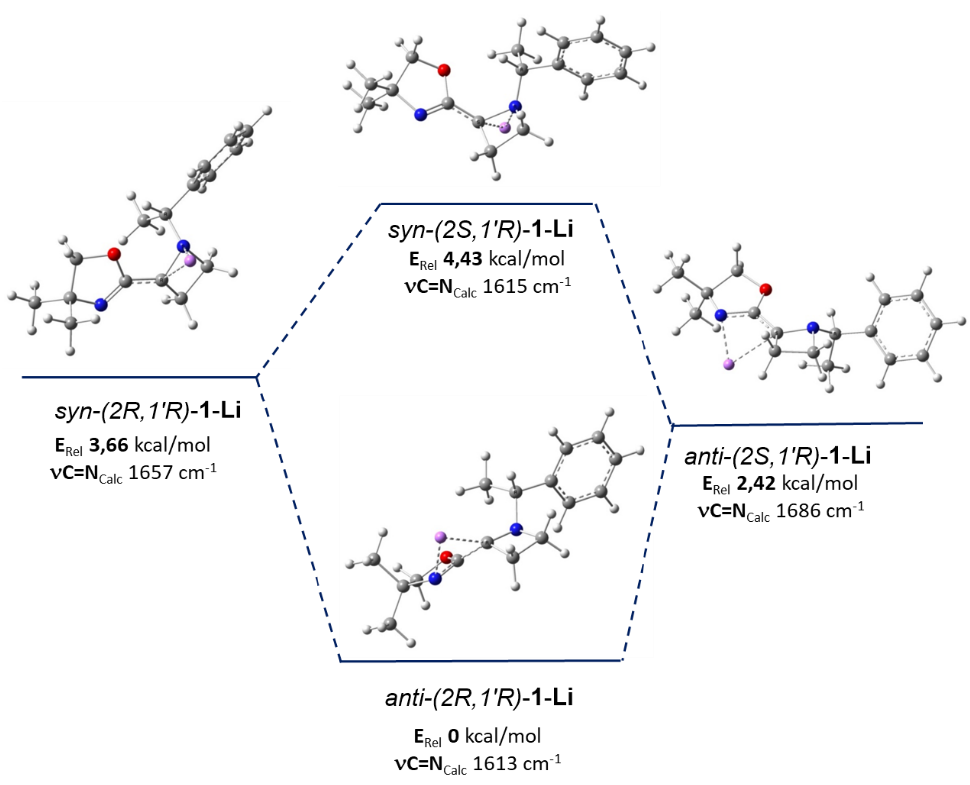
Figure 4. DFT studies towards computing wavenumber for C=N bond and relative energies for the lithiated oxazolinylazetidines calculated by applying IEF-PCM model at the ω B97XD/6-31+G(d,p), solvent: THF.